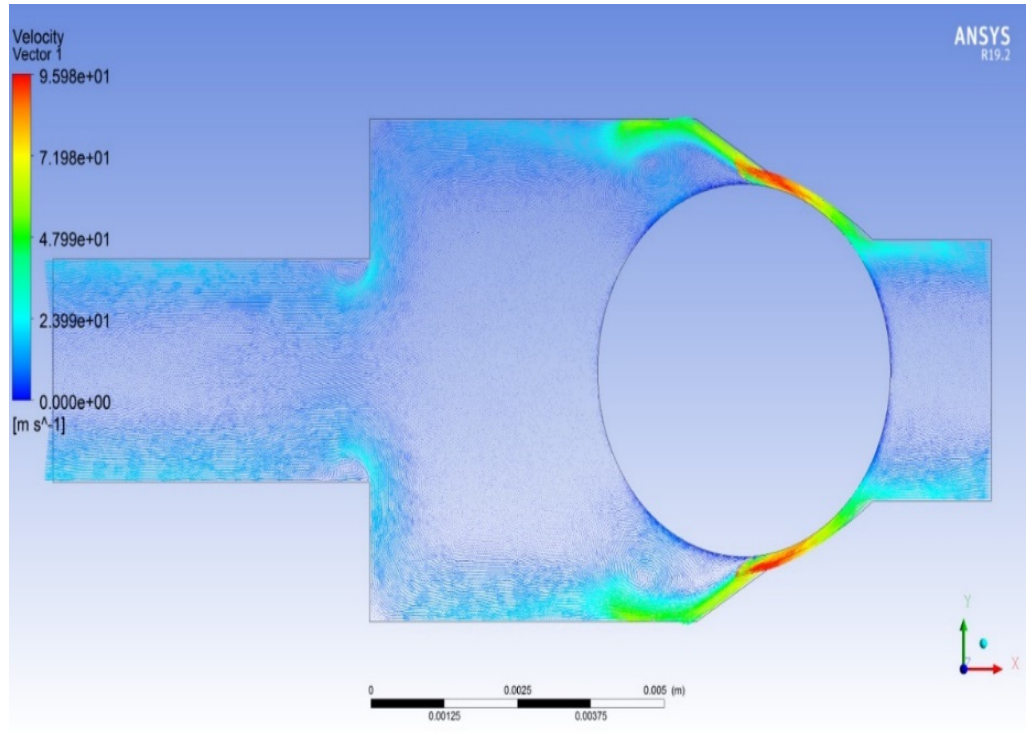
Figure 13. Velocity CFD: Conical Seat Valve: x = 0.201 [mm], pdn = 300 [bar] and pup = 330 [bar].